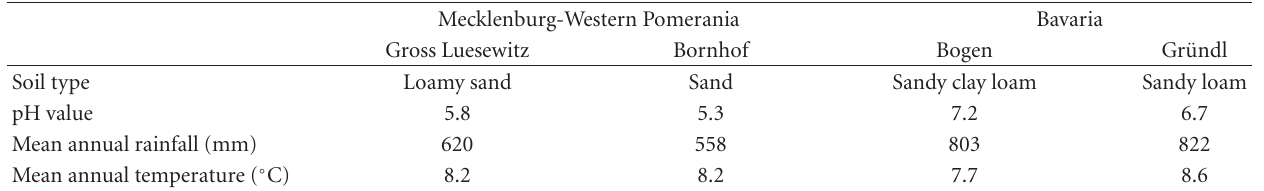
Table 1: Characteristic of locations.